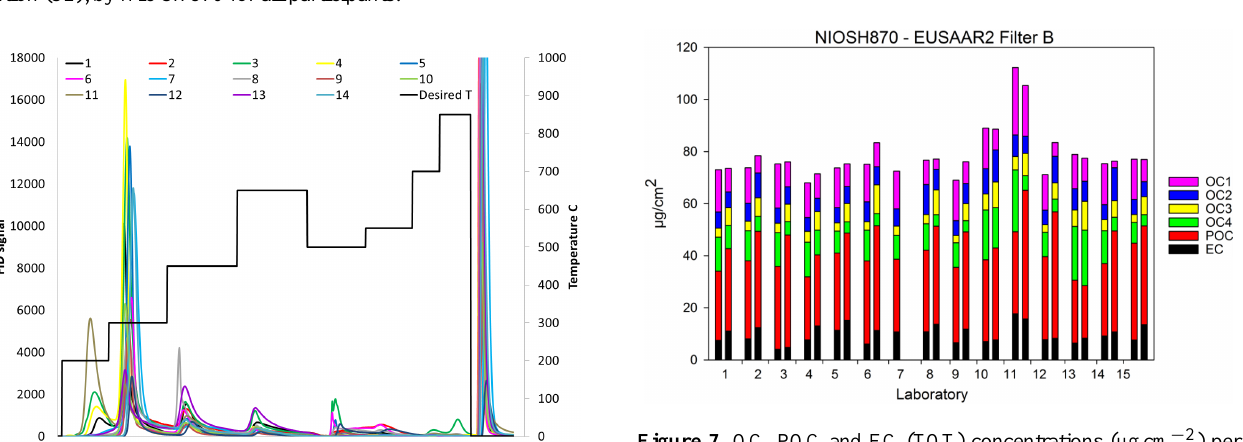
Figure 7. OC, POC and EC (TOT) concentrations (µgcm − 2 ) per temperature step and protocol for PM loaded quartz fibre filter (sam- ple